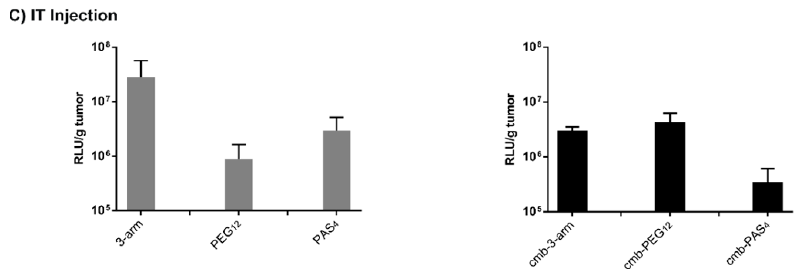
Figure 5. ( A ) Luciferase reporter gene expression in human prostate cancer cell line DU145 as well as in ( B ) human hepatocellular cancer cells Huh7 after 0.75 h (without pattern), and after 24 h (with pattern). Transfections were performed at two different ratios: N/P = 6 (red) and N/P = 12 (green); ( C ) Luciferase gene expression at 48 h after intratumoral administration of pCMVLuc polyplexes at N/P = 12 into Huh7 tumor-bearing mice. Luciferase gene expression is presented as relative light units per gram tumor (RLU/g tumor; n = 5, mean ± SEM). Lysis buffer RLU values were subtracted.